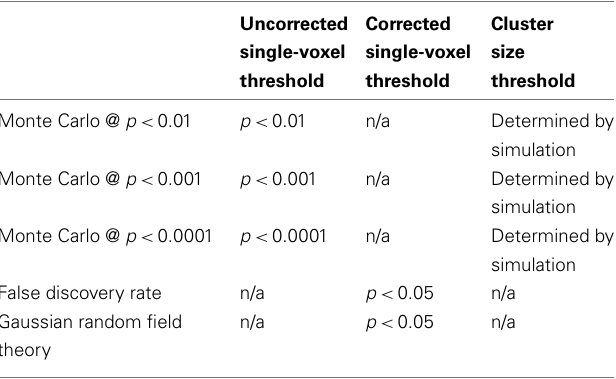
Table 3 | Statistical thresholding